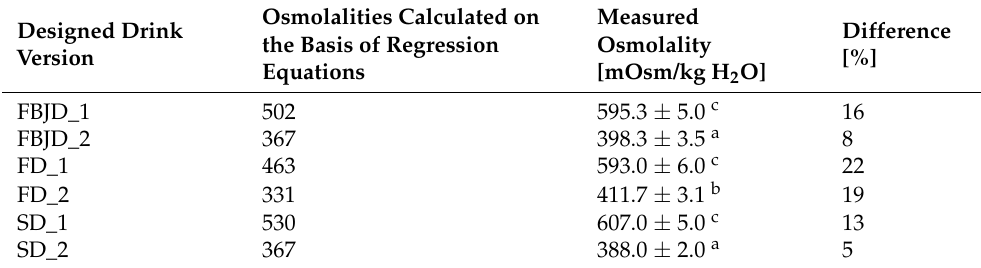
Table 2. Osmolalities of designed drinks.